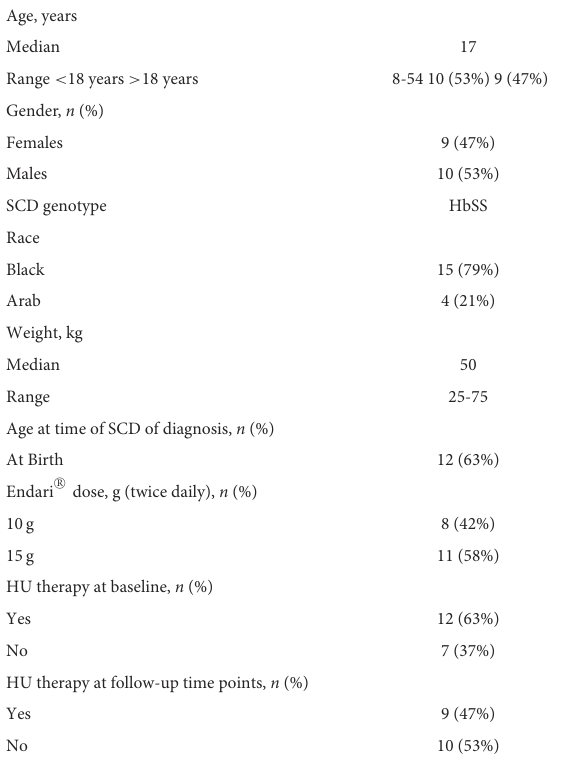
Patients with SCD ( N =